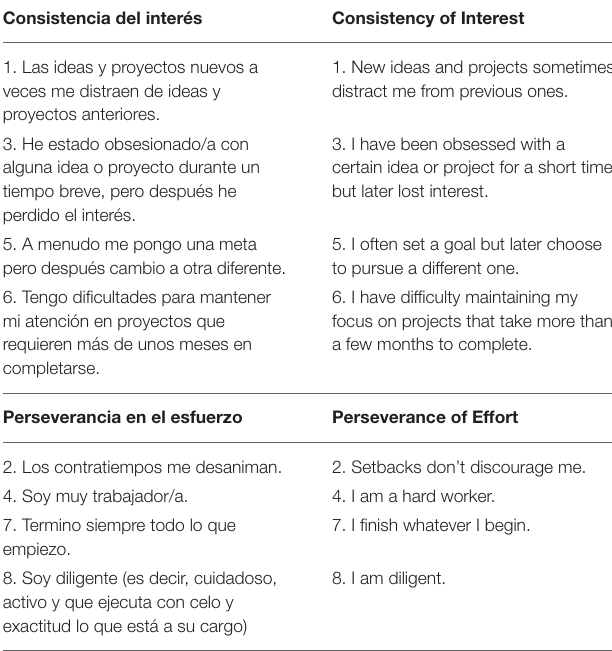
TABLE 1 | Items of the Spanish and Original English Version of the Grit-S Scale arrayed by